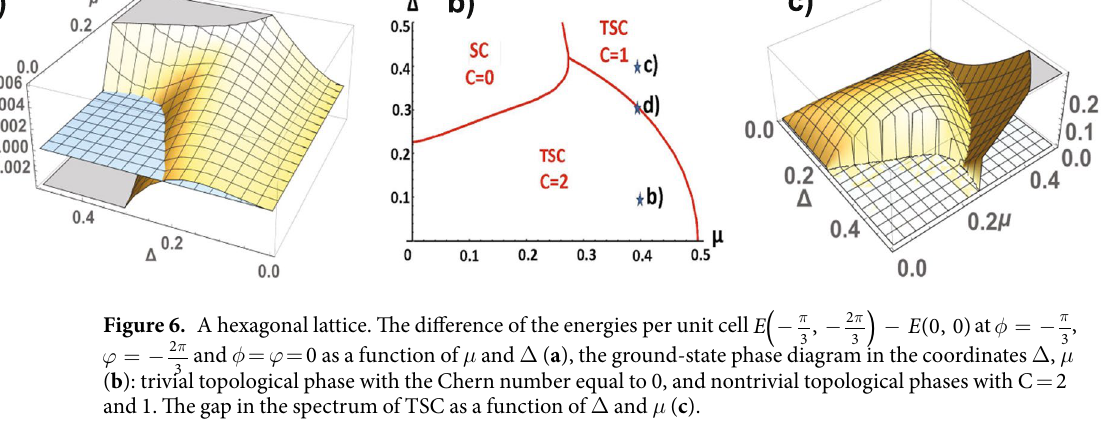
Figure 6. A hexagonal lattice. The difference of the energies per unit cell − − − π π ( ) E E , (0, 0) ϕ = − π 2 and φ = ϕ = 0 as a function of μ and Δ ( a ), the ground-state phase diagram in the coordinates Δ , μ 3 ( b ): trivial topological phase with the Chern number equal to 0, and nontrivial topological phases with C = 2 and 1. The gap in the spectrum of TSC as a function of Δ and μ ( c ).